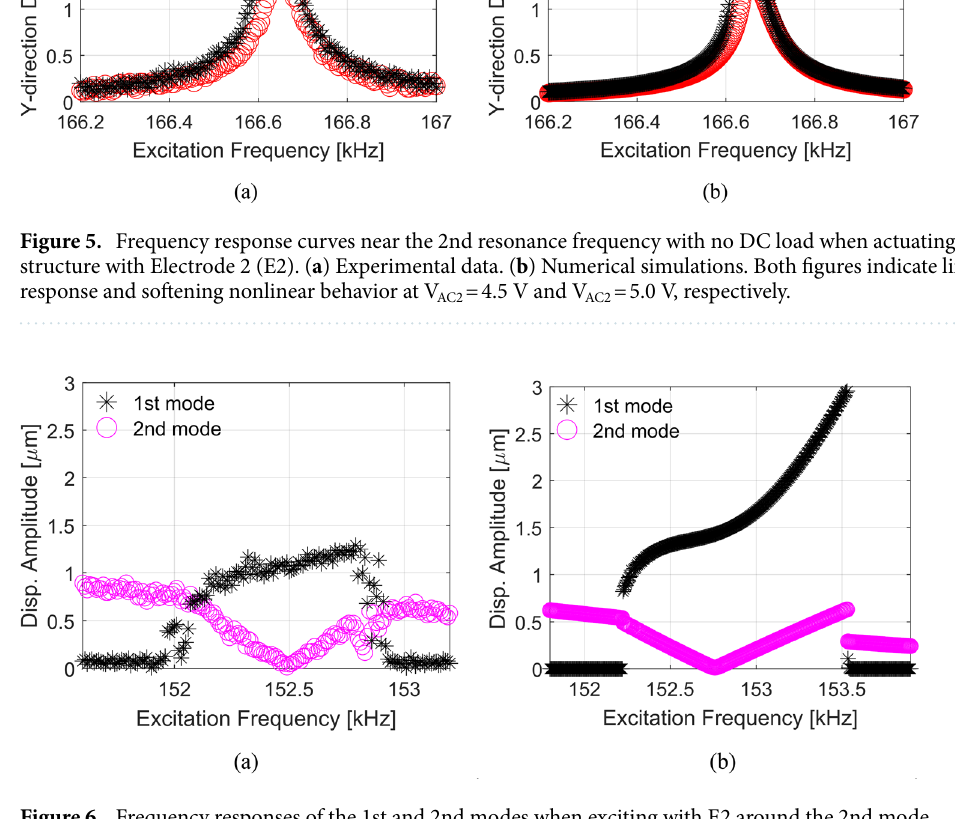
Figure 6. Frequency responses of the 1st and 2nd modes when exciting with E2 around the 2nd mode frequency. ( a ) Experimental data. ( b ) Numerical simulations. Note that due to the 2:1 internal resonance between the modes, the 1st mode, which was previously inactive, gets activated, while the response of the 2nd mode decreases. This shows that the surplus energy injected into the 2nd mode is transferred to the 1st